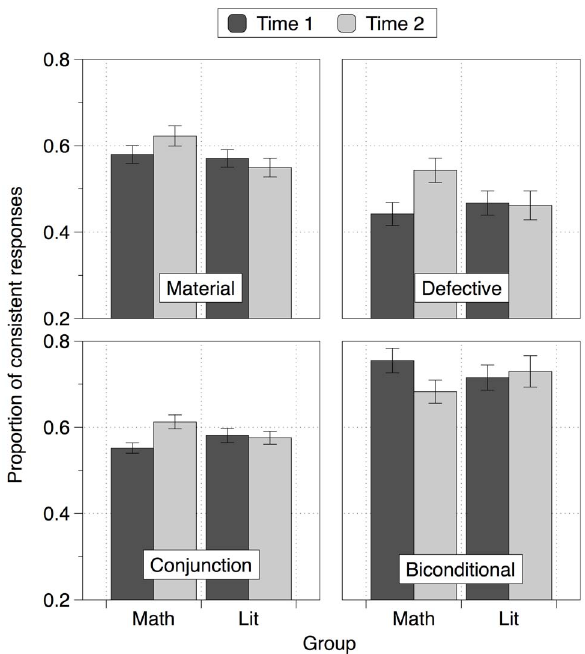
Figure 4. Conditional Inference scores of the two groups at Time 1 and 2, with reference to the four different interpreta- tions of the conditional. Error bars show 6 1 SE of the mean.